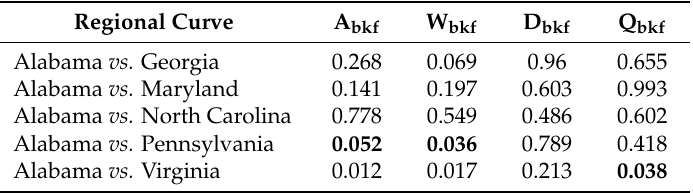
Table 3. Results from separate ANCOVAs to compare Alabama Piedmont regional curves to Piedmont regional curves from other states. Values are p- values (significant values in bold) from the interaction term in a linear model assessing drainage area, data source, and drainage area*data source on channel dimension variables. Source data for comparisons include Georgia [32], North Carolina [33], Virginia [24], Maryland [23], and Pennsylvania [7]. Regional Curve A bkf W bkf D bkf Q bkf Alabama vs. Georgia